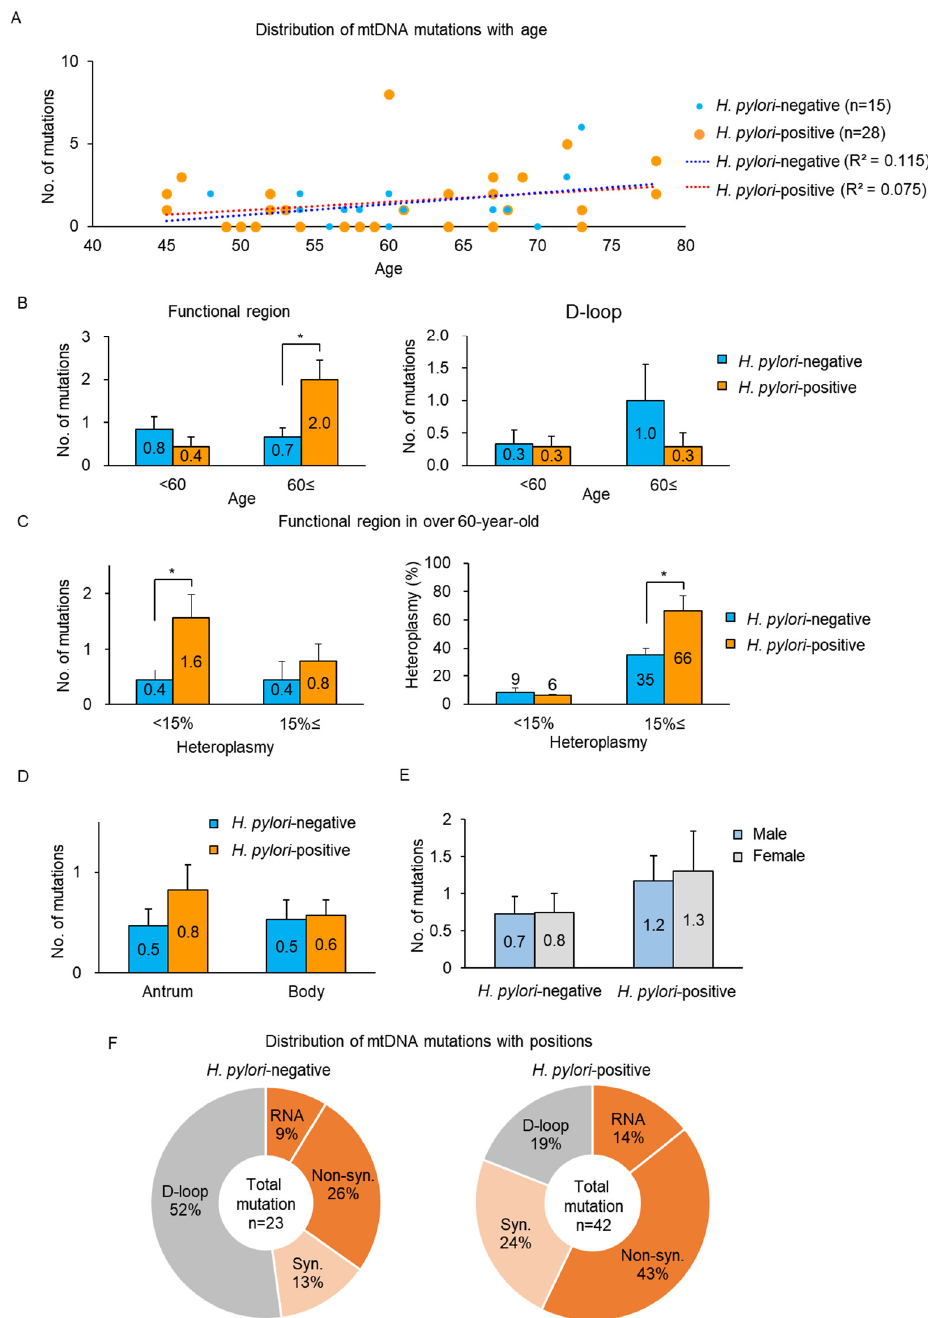
Figure 5. mtDNA mutations detected in H. pylori -negative and -positive populations. ( A ) Distribution of mtDNA mutations with age in H. pylori -negative ( n = 15) and -positive populations ( n = 28). There was no significant difference between H. pylori -negative and positive populations when analyzed by regression analysis. R 2 means Pearson’s r values. ( B ) There was a significant increase in number of mtDNA mutations in functional region at the age of 60 years or older in the H. pylori -positive population (* p < 0.05). D-loop showed similar numbers between H. pylori -positive and -negative populations ( H. pylori -positive: <60, n = 14 and 60≤, n = 14; H. pylori -negative: <60, n = 6 and 60≤, n = 9). ( C ) Increased number and heteroplasmy of mtDNA mutations at age of 60 years or older in H. pylori -positive population. Number of mtDNA mutations under 15% heteroplasmy and heteroplasmy of mtDNA mutations above 15% heteroplasmy were significantly increased (* p < 0.05) in H. pylori -positive population ( H. pylori -positive: n = 14; H. pylori -negative: n = 9). ( D ) mtDNA muta- tions in functional regions preferentially occurred in antrum of the stomach of H. pylori -positive population. Body had similar numbers of mtDNA mutations in H. pylori -negative and -positive